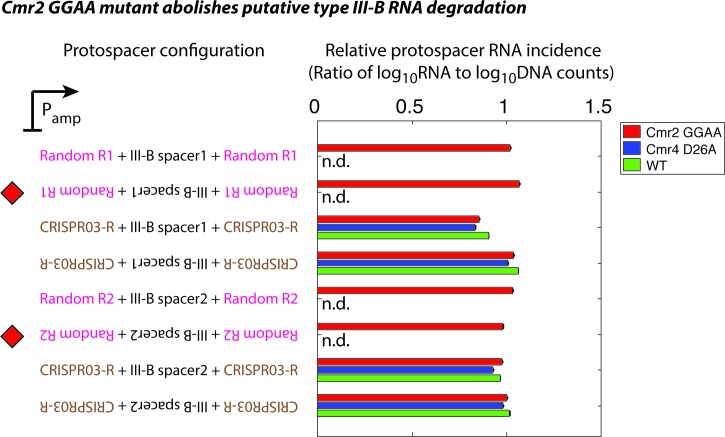
Effect of Cmr2 and Cmr4 active site mutations on protospacer RNA levels during putative type III-B RNA targeting.Wildtype (WT), Cmr2 GGAA, and Cmr4 D26A strains were transformed with plasmids from the interference assay, and tested for the presence of RNA from the protospacer regions by targeted RNAseq. All plasmid configurations from Figure 1C were tested in the Cmr2 GGAA mutant strain (red). In the presence of functional type III CRISPR-Cas-mediated RNA degradation, a drastic reduction in the RNA levels for the configurations marked with red diamonds would be expected. Based on our data, we cannot distinguish between the possibilities that the M. mediterranea type III-B system lacks RNAse activity altogether, or that the Cmr2 GGAA mutation abolishes RNA degradation. This contrasts with S. epidermidis where the Cmr2 PALM domain is necessary for DNA interference, but not for target RNA cleavage (Samai et al., 2015). The plasmids marked with red diamonds are not stable in WT (green) or the Cmr4 D26A mutant (blue); this precluded us from determining whether these strains displayed RNase activity (n.d.: not determined). Although we do not see evidence for RNA degradation by the M. mediterranea type III-B system, it is conceivable that a Cmr2-dependent RNA-targeting pathway is present.